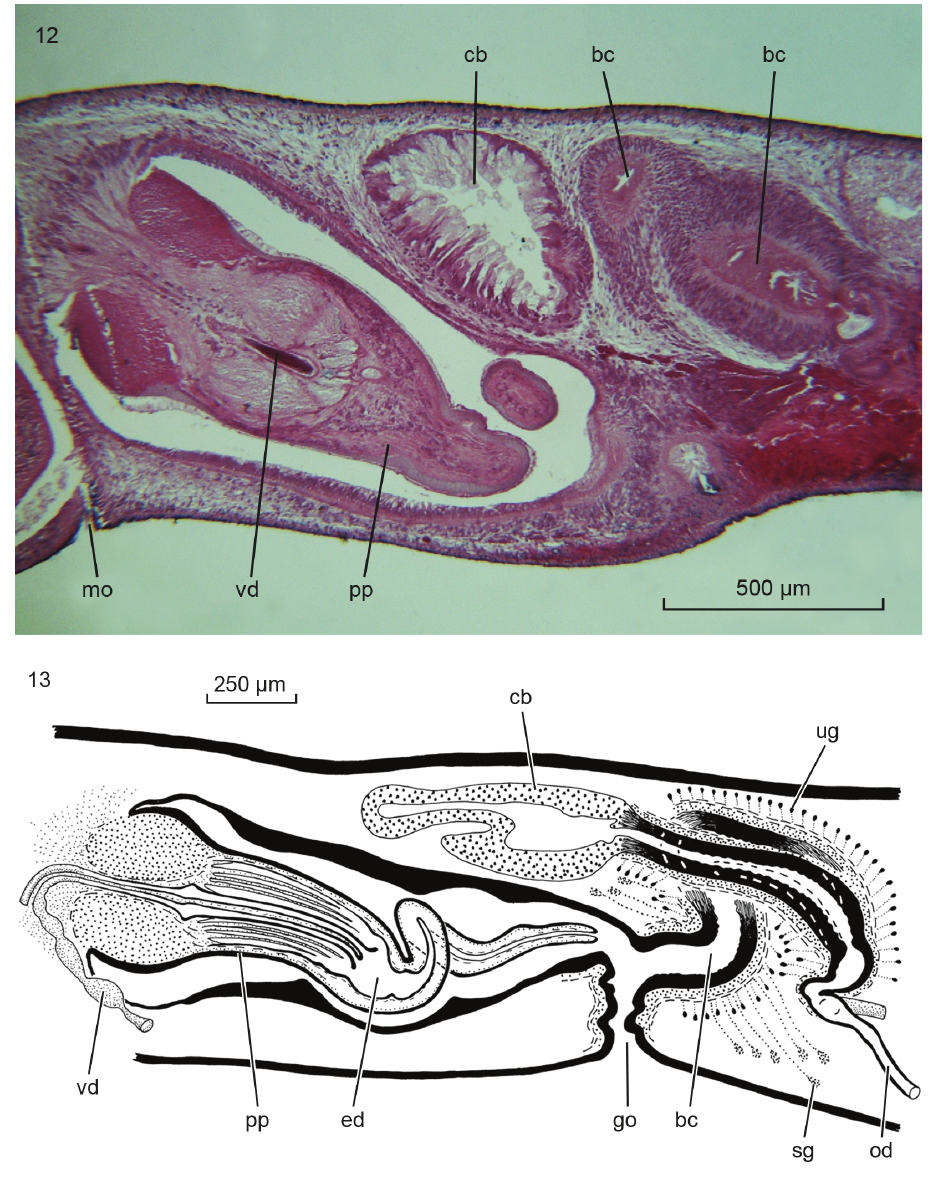
section of copulatory apparatus of holotype of Procerodes sanderi ; anterior to the left 13 MZU PL. 00291(nos. A788-821), sagittal reconstruction of the copulatory apparatus of presumed specimen of Procerodes sanderi